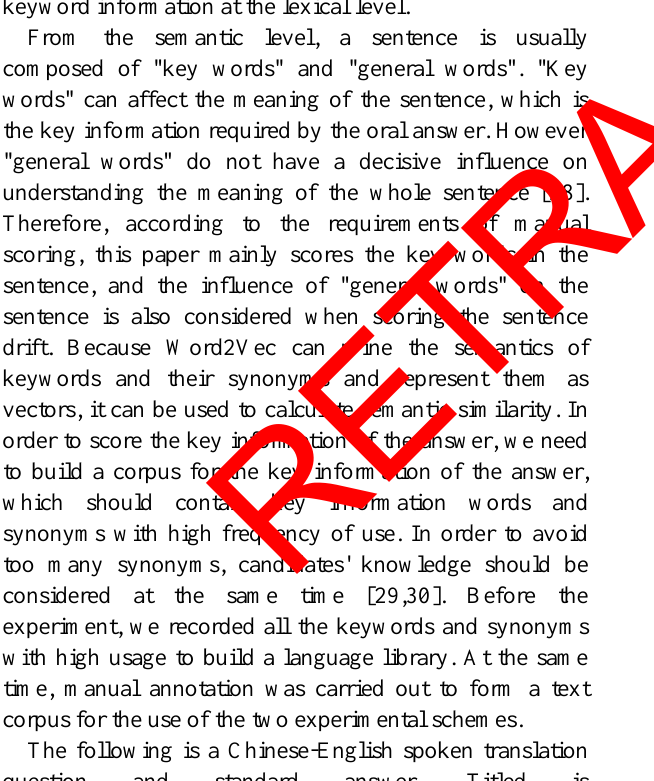
Figure 1. Semantic tree